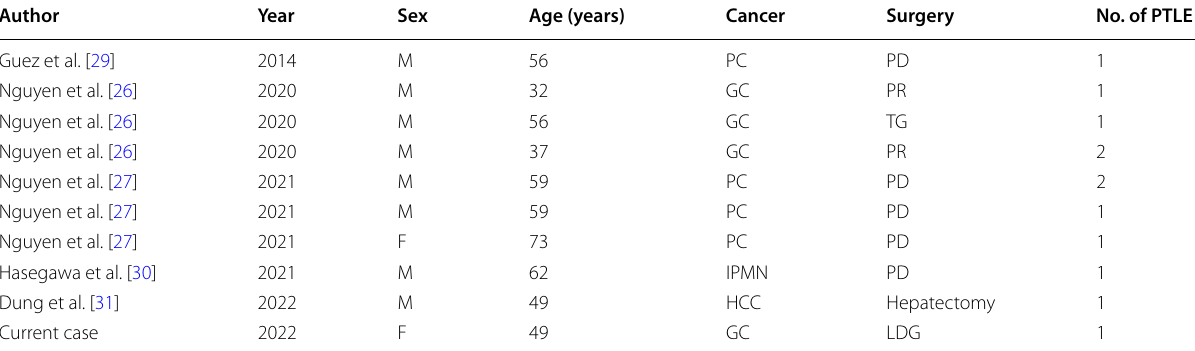
Table 2 Successful cases treated by percutaneous transhepatic lymphangiography and embolization of hepatic lymphorrhea after surgery for digestive